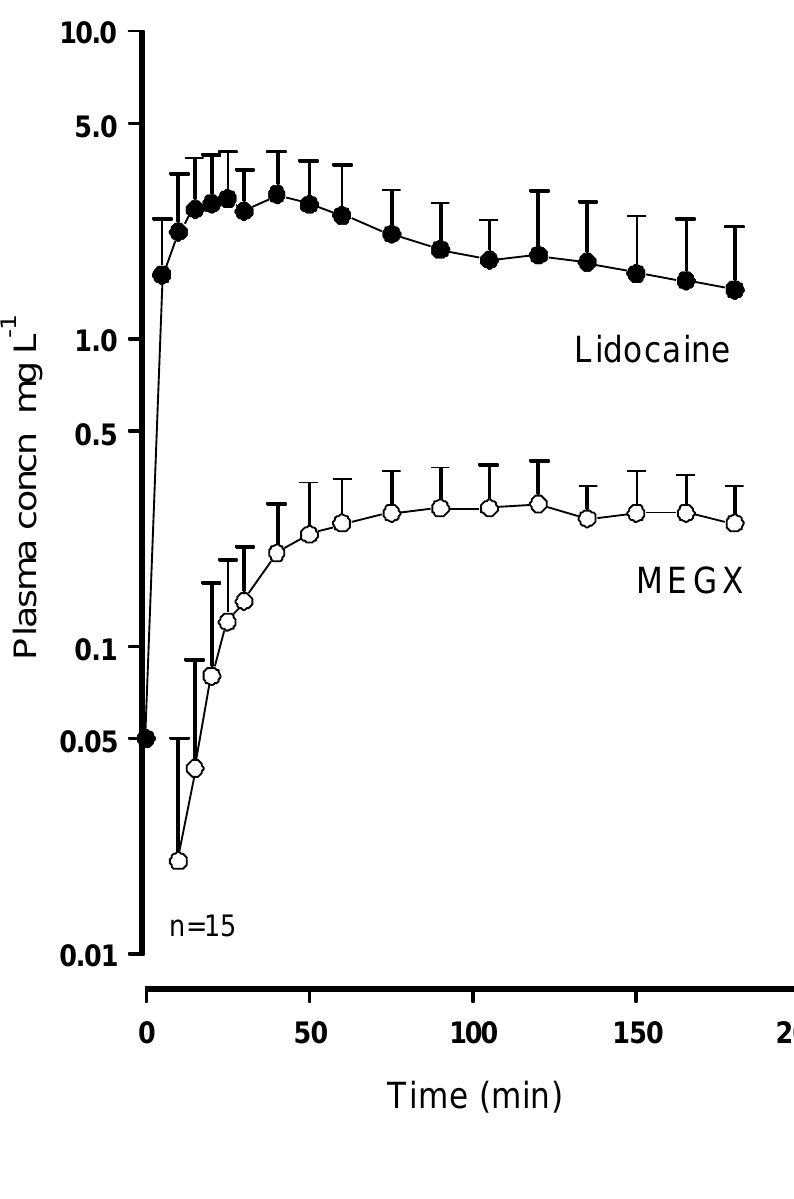
FIGURE 2 . Mean plasma concentration–time curves of lidocaine (mg l –1 ± s.d.), its metabolite MEGX after axillary administration of 600 mg lidocaine (+ 5 m g ml –1 adrenaline) (n =